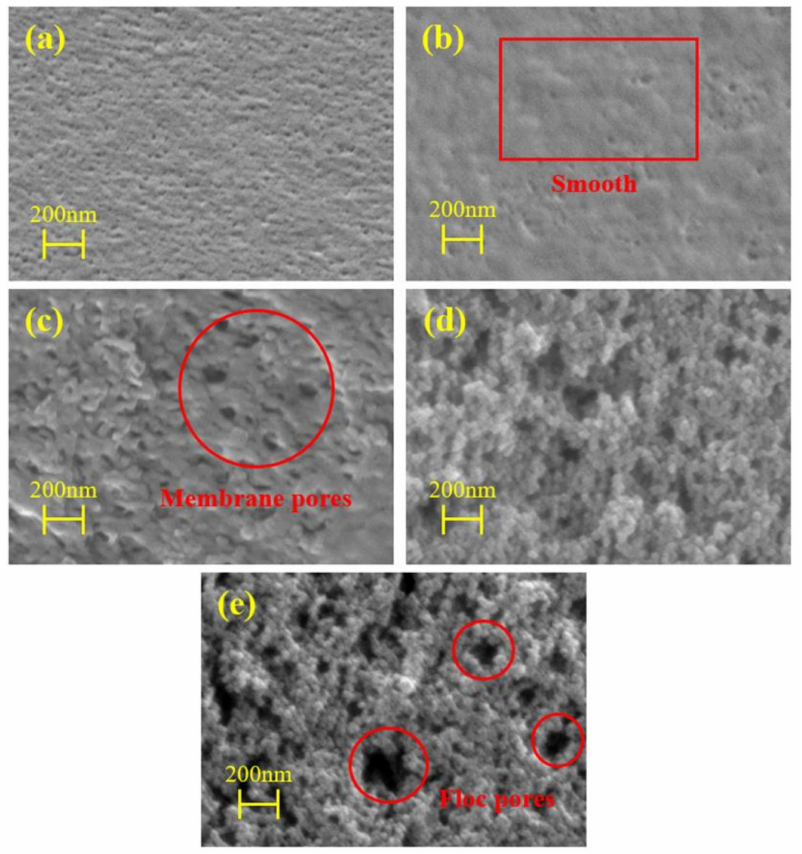
Figure 5. SEM images of membrane surface: ( a ) original membrane; membrane after ( b ) raw water filtration; ( c ) pretreatment of 60 µ M PMS; ( d ) pretreatment of 60 µ M Fe(III) and ( e ) pretreatment of 60 µ M Fe(II)/60 µ M PMS. Conditions: EHT = 15 kV, Mag = 20.00